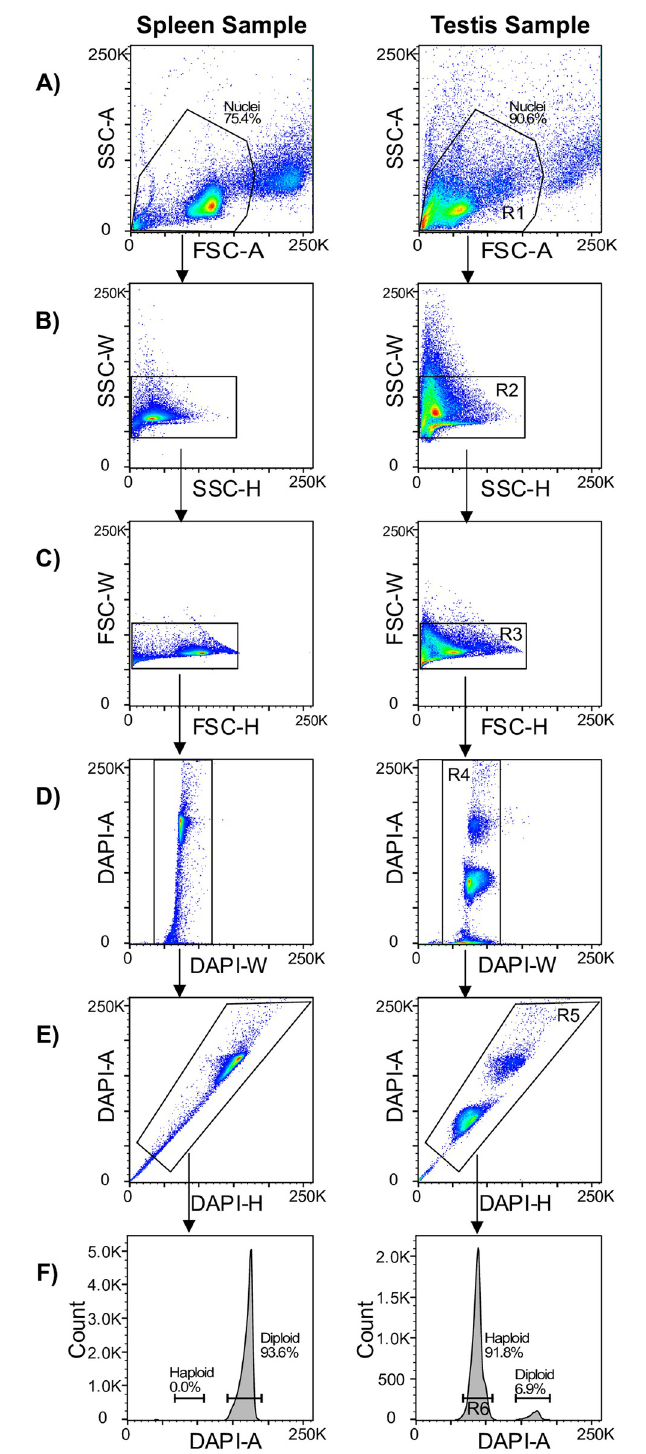
Fig 2. Flow cytometric gating strategy for the isolation of haploid cells. The following gating steps are applied sequentially, as indicated by the arrows i.e. all events in ‘B’ represent only the gated events from ‘A’ and so on to ‘F’. (A) Nuclei are isolated from the rest of the population initially using linear forward scatter area (FSC-A-lin) and linear side scatter area (SSC-A-lin) by region gate 1 (R1). (B) Single nuclei are isolated using: region gate 2 (R2) on linear side scatter width (SSC-W-lin) and linear side scatter height (SSC-H-lin); (C) region gate 3 (R3) on linear forward scatter